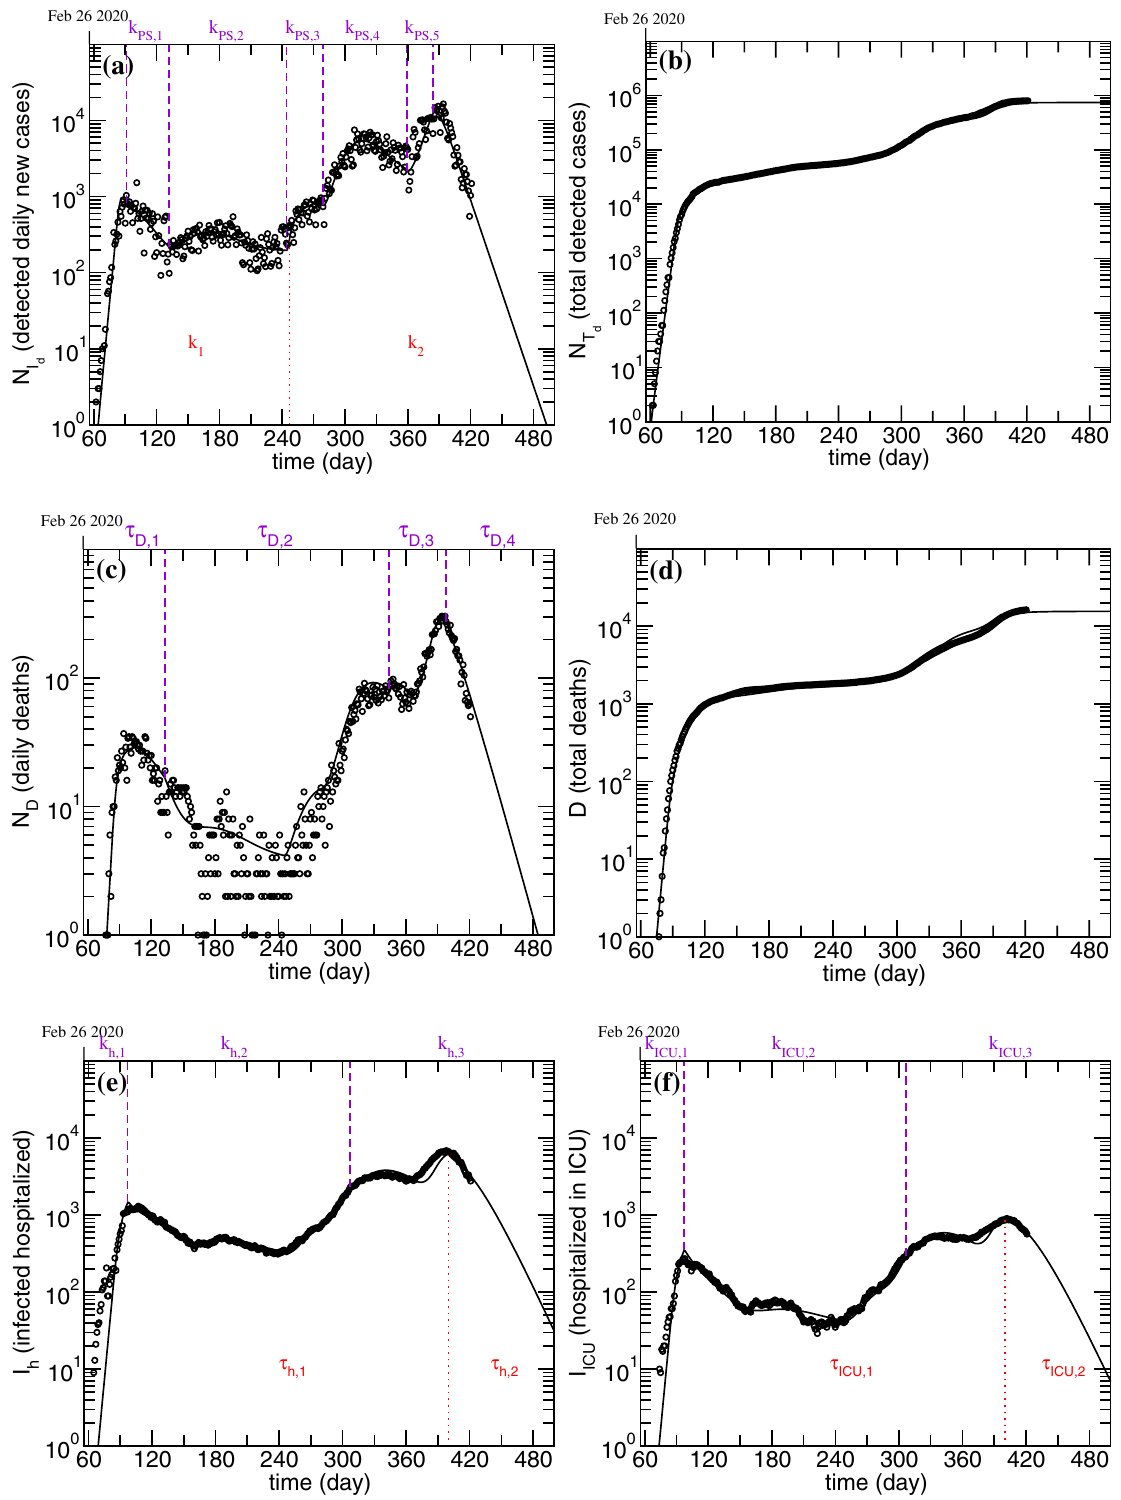
Figure 3. Model fitting results obtained for the application of the modified PSEIRD(S) model to the different data sets, starting from the assumptions presented in Table 1. The details regarding the auxiliary lines are explained in the